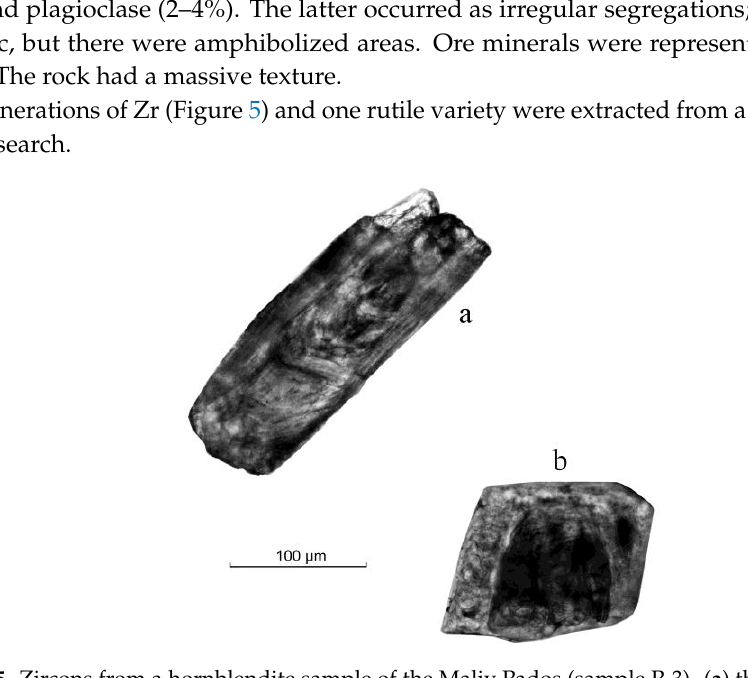
Figure 5. Zircons from a hornblendite sample of the Maliy Pados (sample P-3). ( a ) the first generation of Zr; ( b ) the second generation of Zr.